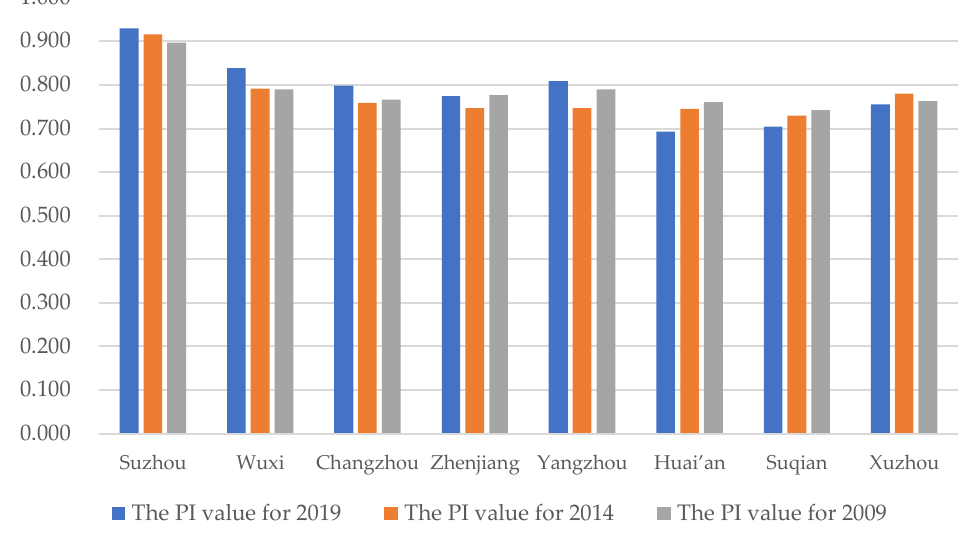
Figure 4. Comparative diagram for 2009–2019.